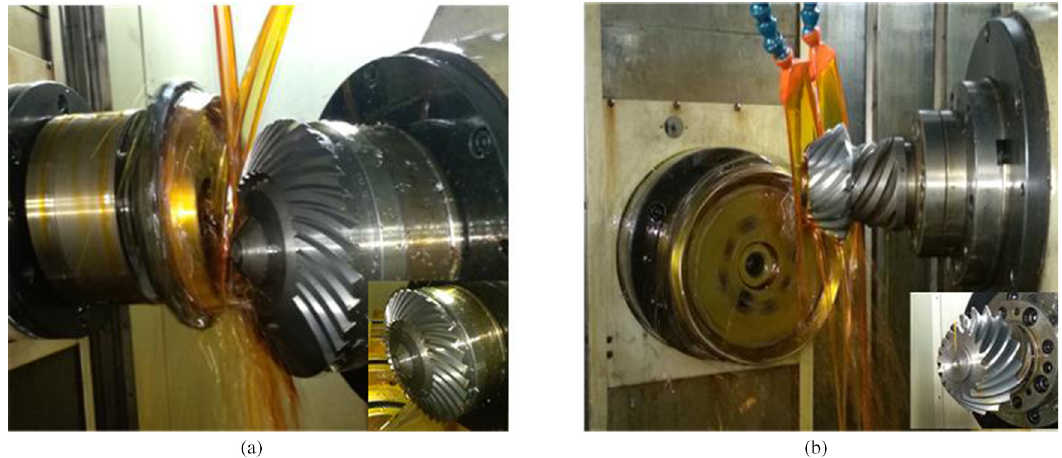
Fig. 13. Cutting experiment. (a) Gear. (b)